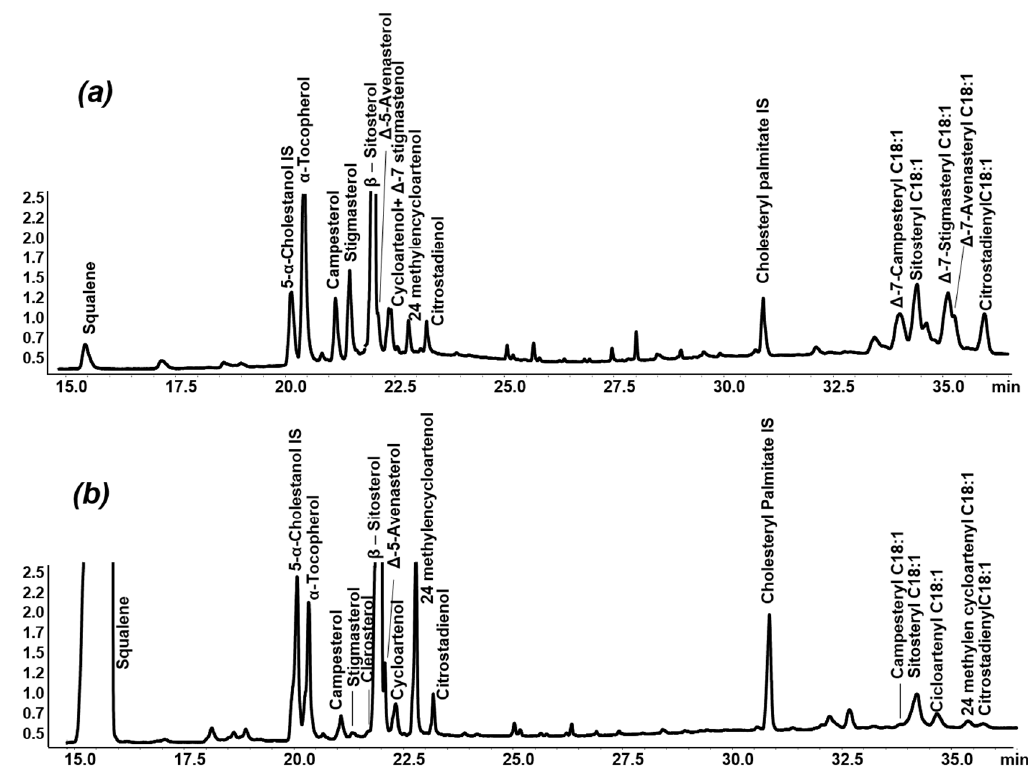
Figure 1. GC-FID chromatograms of TMS free and esterified minor compounds in refined high-oleic sunflower ( a ), and extra virgin olive ( b ) oils; for fatty acids. Note: m:n—m = number of carbon atoms, n = number of double bonds.